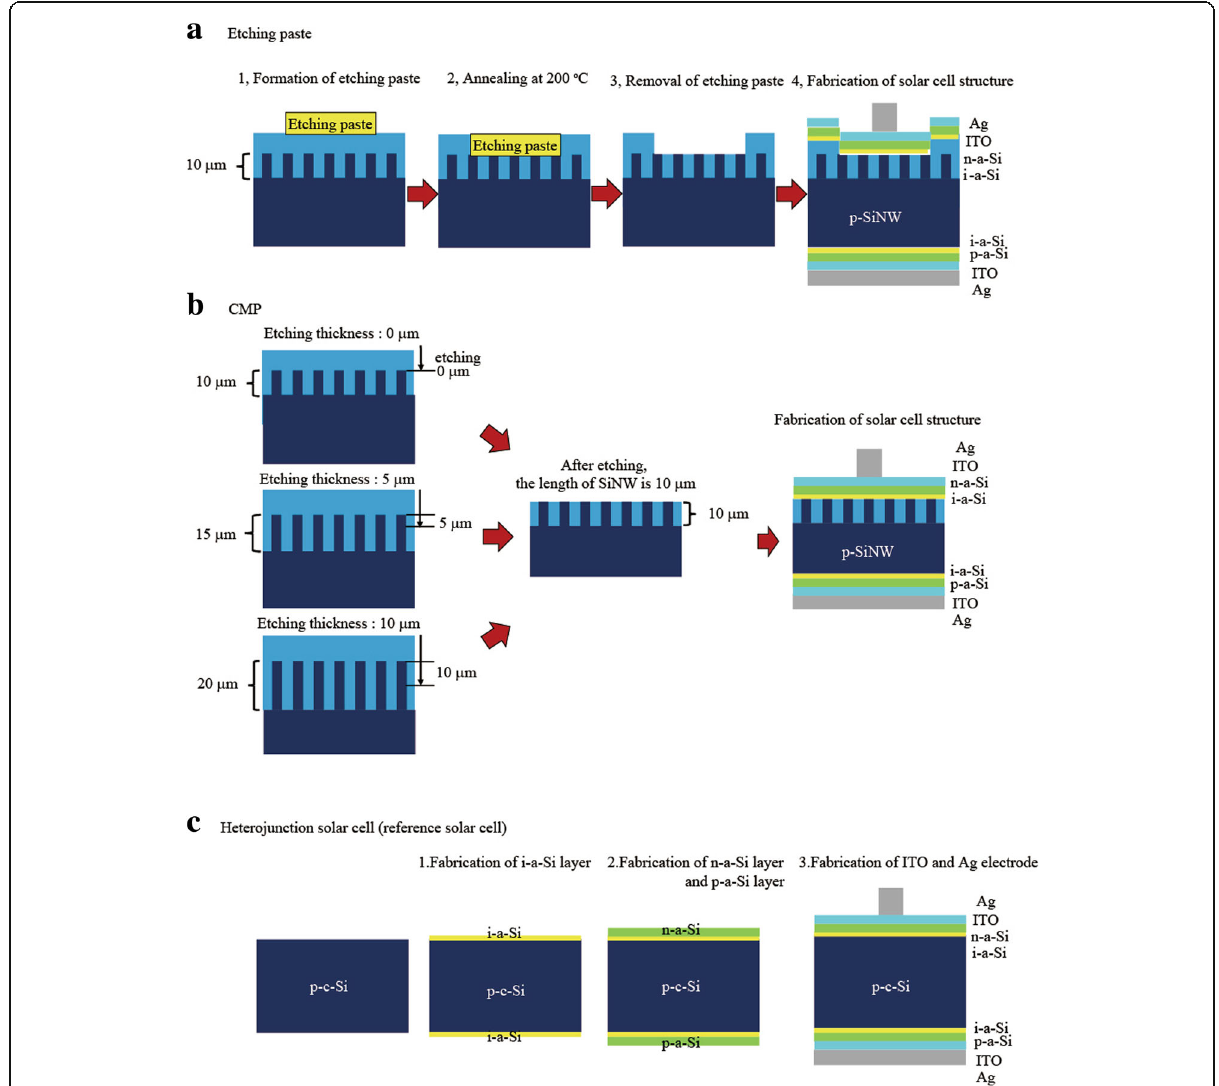
Fig. 2 Al 2 O 3 etching procedure and fabrication procedure of solar cell: a etching paste and b CMP. c Heterojunction solar cell (reference solar